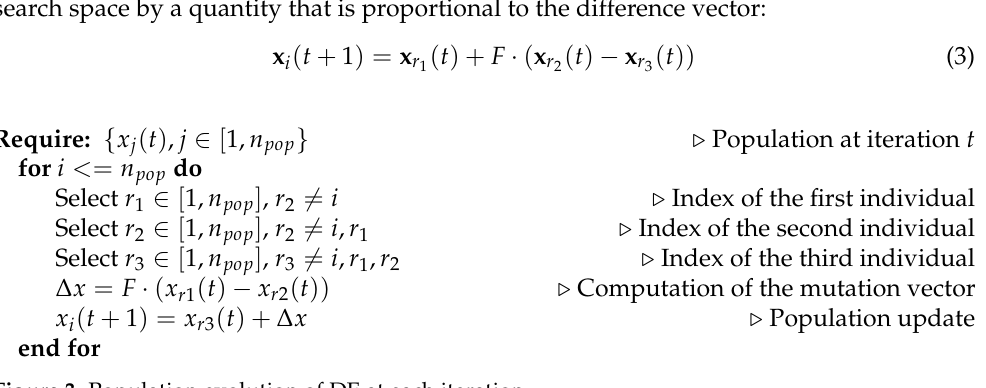
Figure 3. Population evolution of DE at each